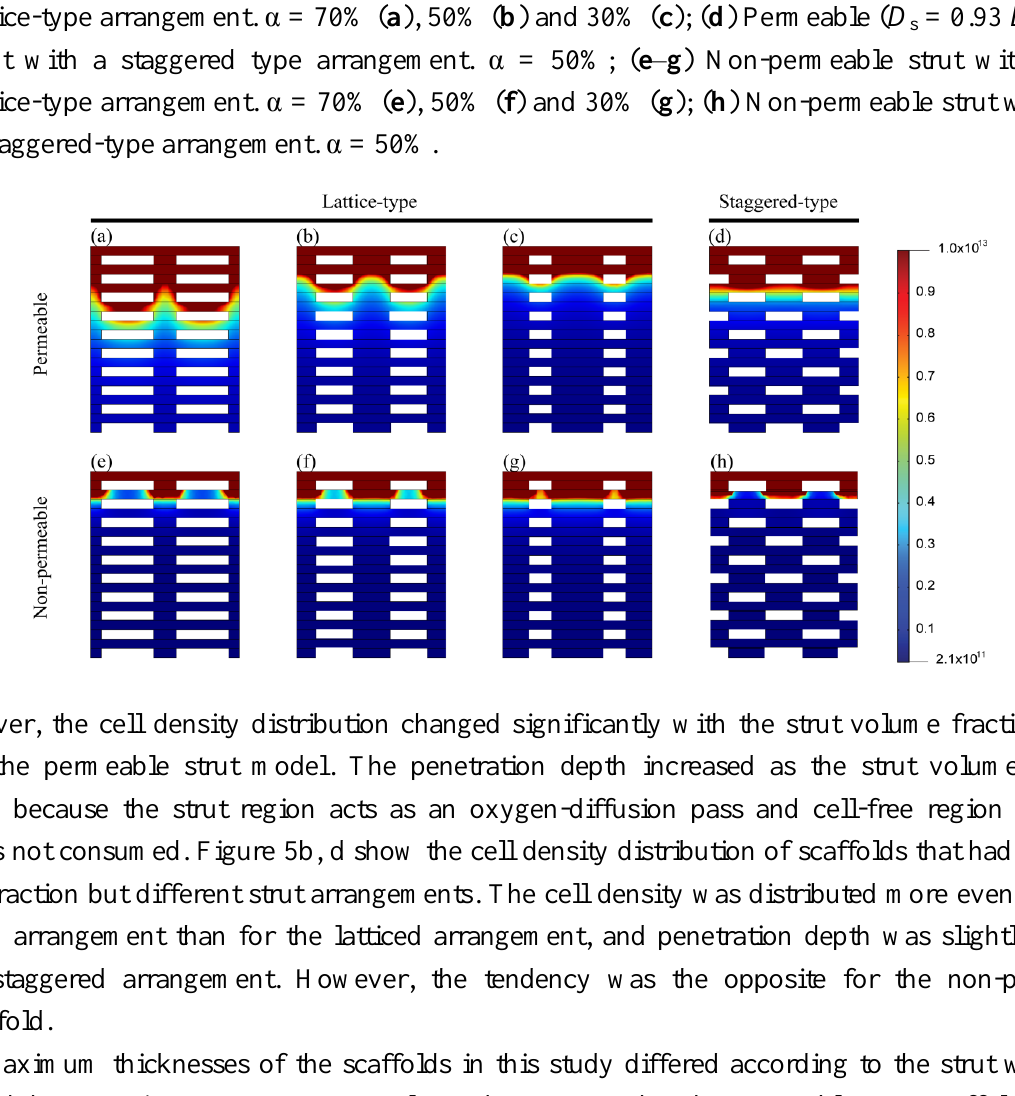
. ( a – c ) Permeable ( D = 0.93 D ) strut with a s s w = 0.93 D ) s w